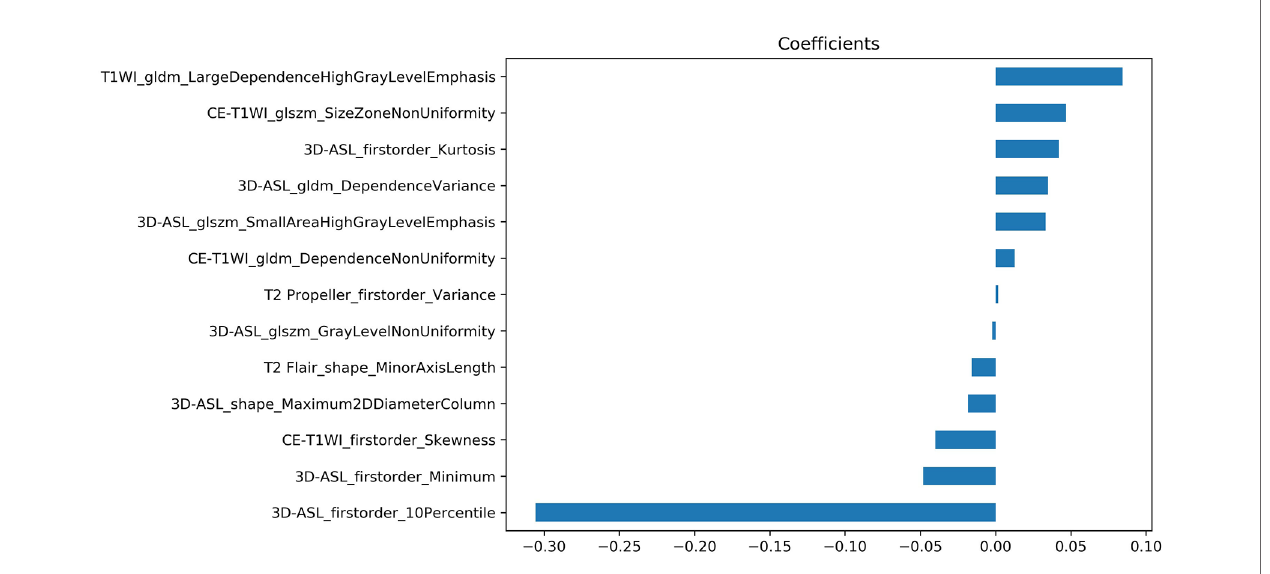
FIGURE 3 | The coef fi cients of screened features using the LASSO regression.